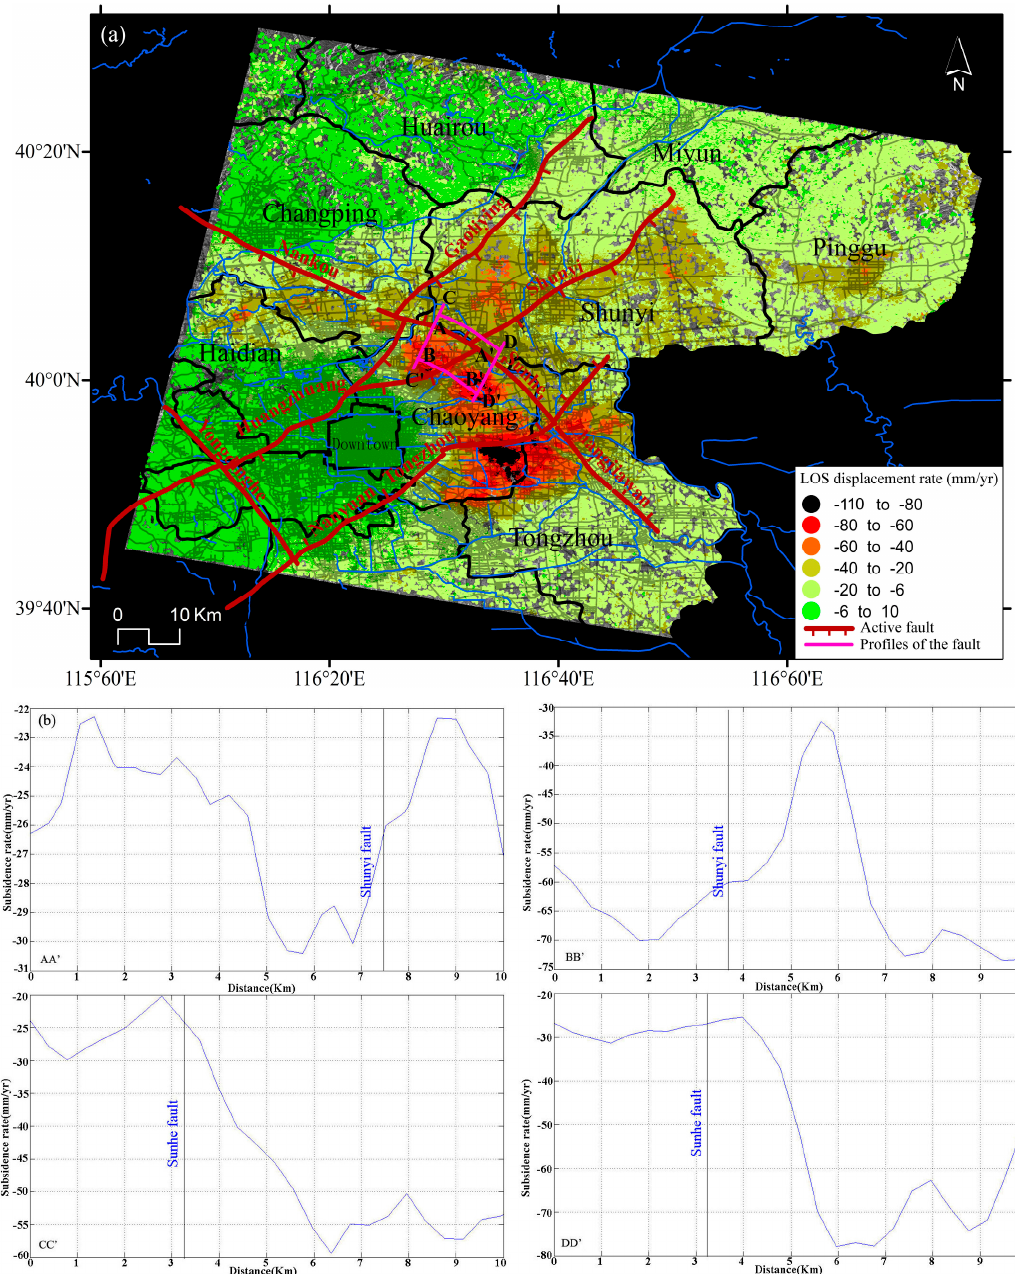
Figure 10. ( a ) Overlap of main active faults (based on [40]) to InSAR displacement rates; ( b ) Land subsidence profiles along the Nankou-Sunhe fault.